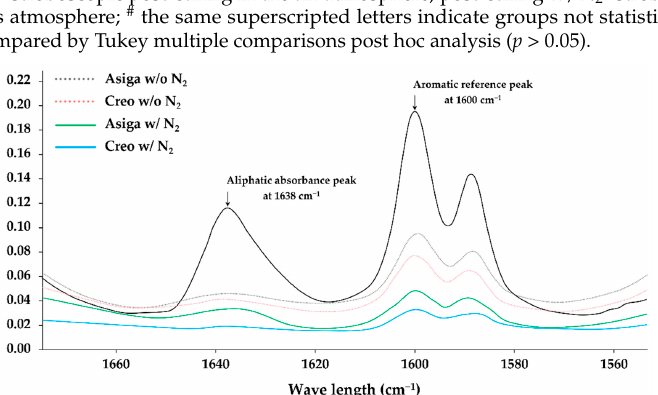
Figure 4. The typical IR spectra of the aliphatic absorbance peak and the aromatic reference peak used for DC% calculation. The representative plots of mass changes in time (%) during the water sorption and solubility test are shown in Figure 5. The saturation was reached 7 days after water im- mersion in all groups. During the second dying procedure, all groups were completely dried up 15 days after drying began. The typical images obtained by the OP and SEM are shown in Figure 6. Additionally, the typical cross-sectional profiles which were vertical to the printing direction are shown in Figure 7. The OP images revealed the greater and